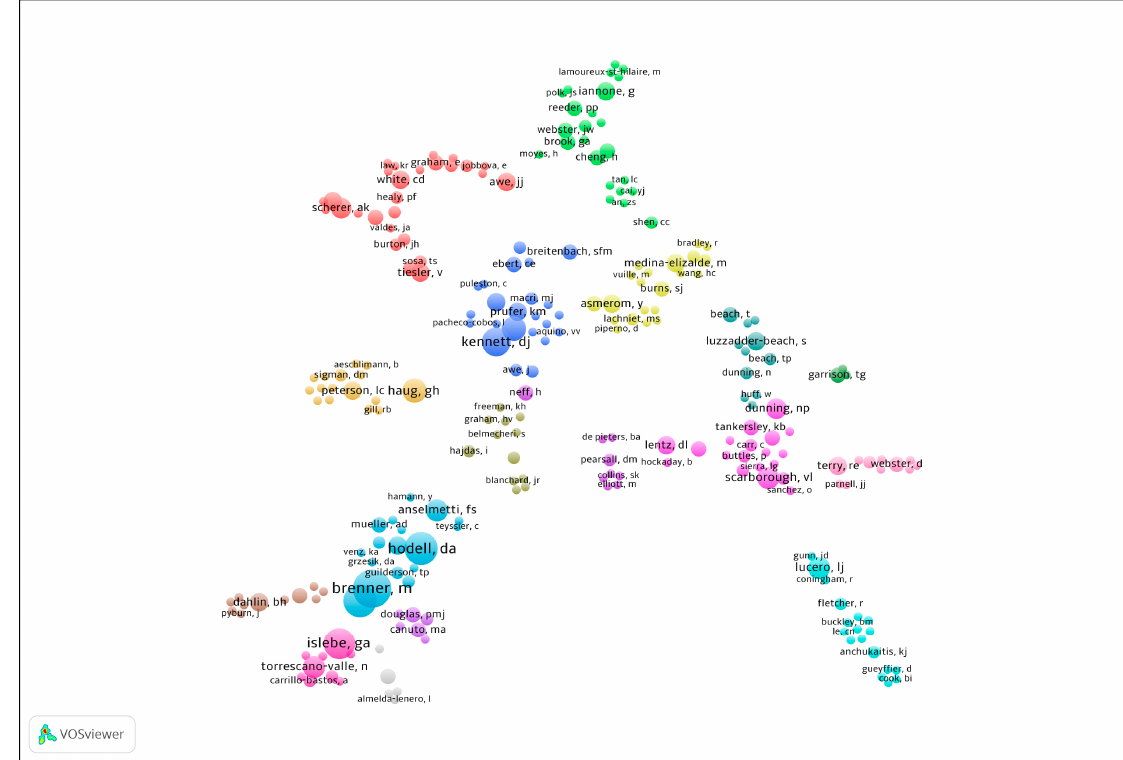
Figure 3. Co-authorship map of all authors from the 433 Maya collapse papers (the minimum number of papers containing a specific author is one). Source: WoS, VOSviewer.